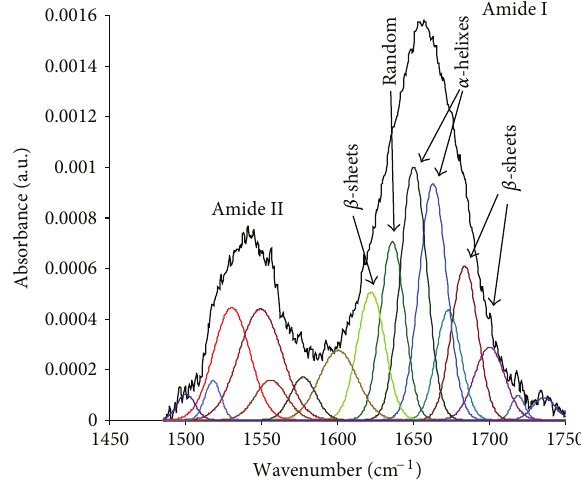
F 15: Fitting results of Amide I and II region in FTIR ATR spectra of dry attached HRP on PIII-treated polyethylene.